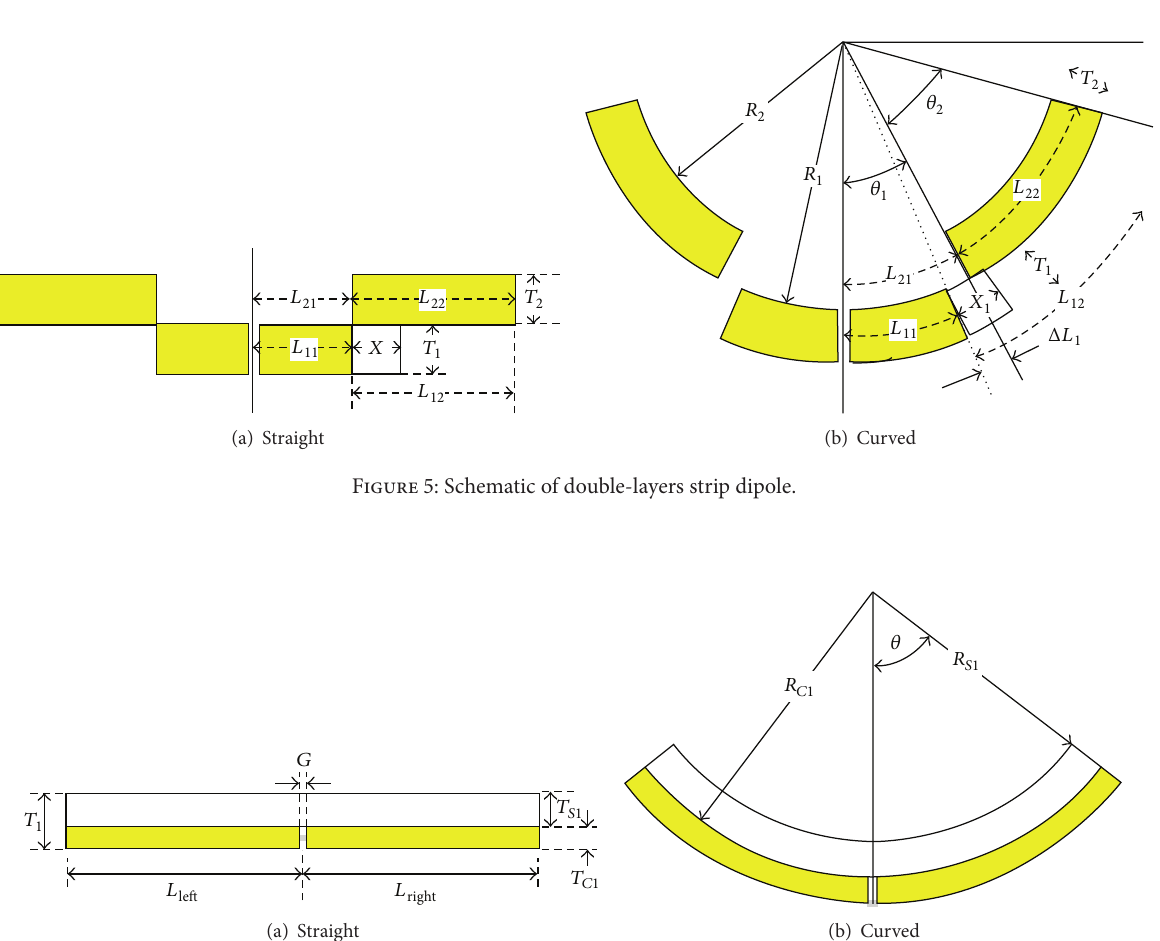
Figure 6: Schematic of single-layer strip dipole antenna design with flexible copper-clad laminate.